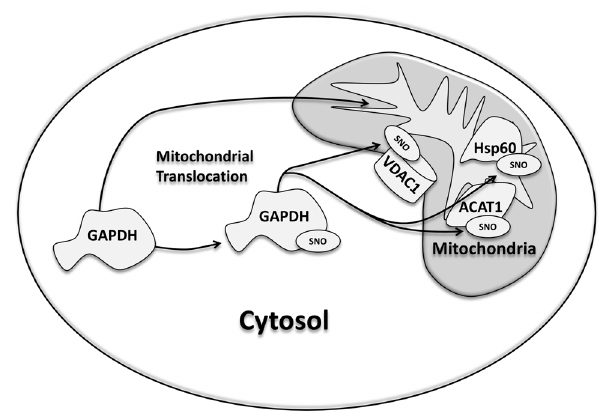
Figure 8. GAPDH acts as a mitochondrial trans-S-nitrosylase. GAPDH and SNO-GAPDH can be imported into the mitochondria, where SNO-GAPDH targets Hsp60, ACAT1, and VDAC1 as a mitochondrial trans- S